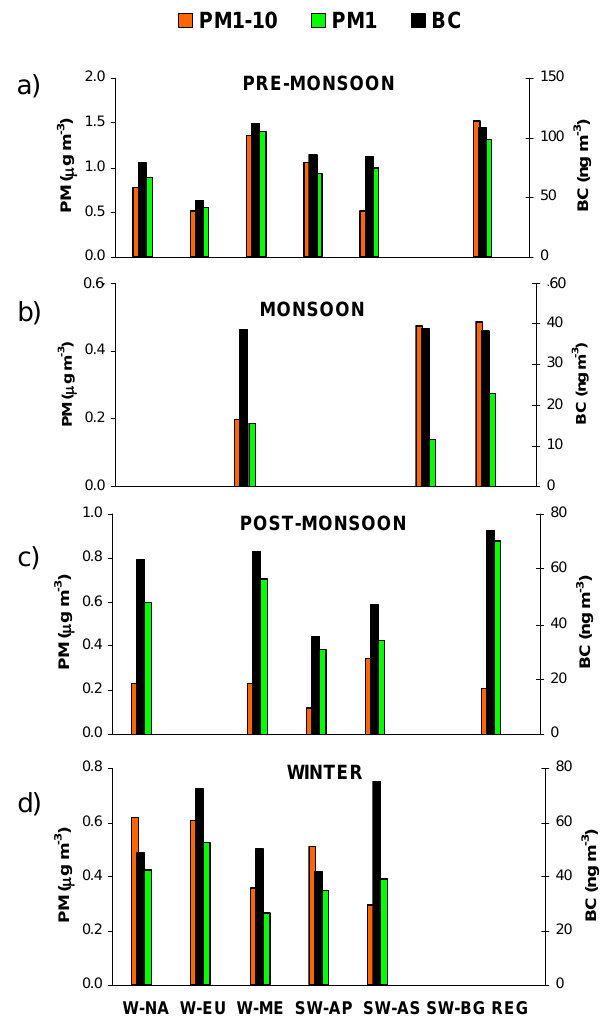
Fig. 6. PM 1 , PM 1 − 10 and BC (average values) classified with different synoptic air mass circulation as defined by Bonasoni et al. (this issue), during (a) pre-monsoon, (b) monsoon, (c) post- monsoon and (d) winter